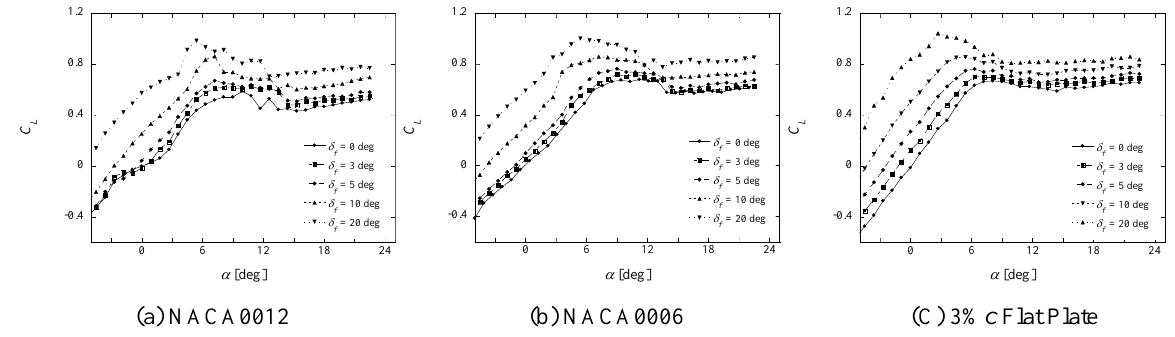
Fig. 7 Lift curves for each airfoil with flap deflection at Re = 20,000. Small lift-curve slope and high non-linearity of the lift curves cause low lift increase even though the flap deflection angle increases. The lift curves of 3% c flat plate with high lift-curve slope and high linearity keep the linearity at each flap deflection angle, and the lift coefficients increase at an almost constant rate as flap deflection angle